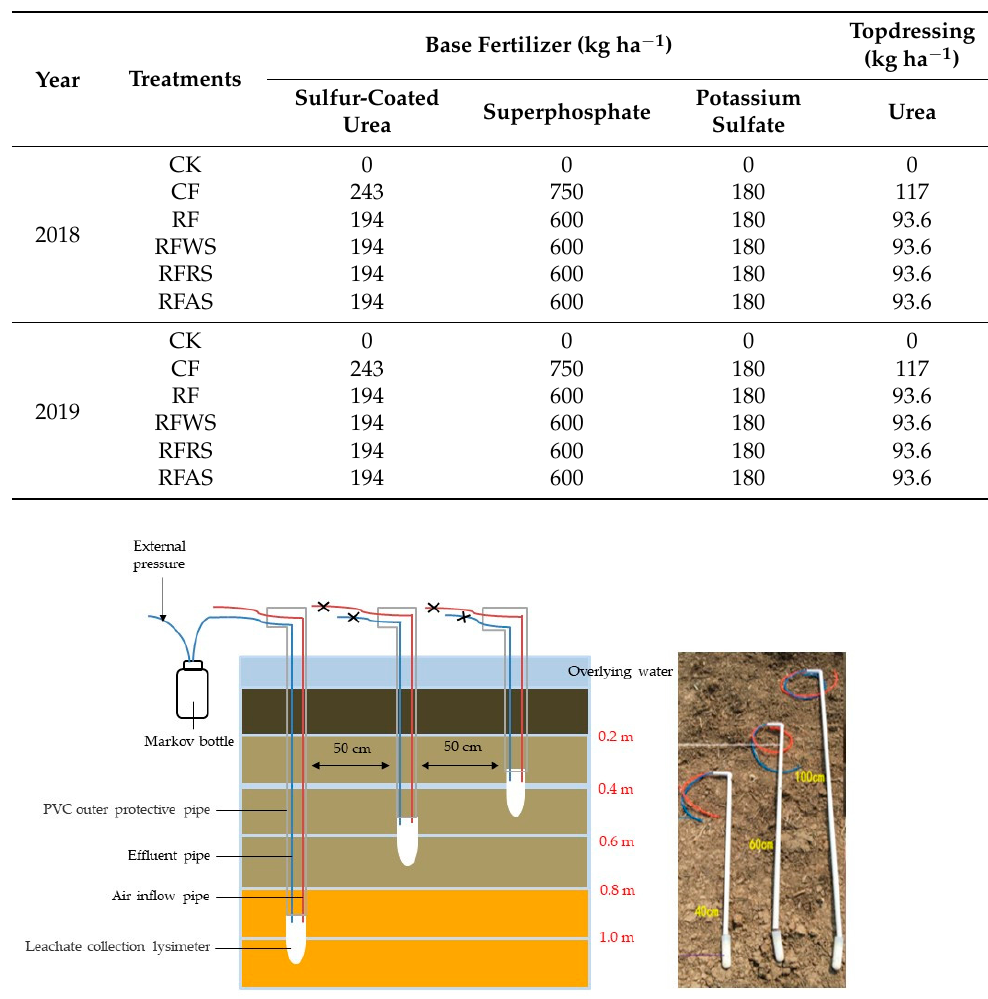
Table 1. The amount of fertilizer applied.